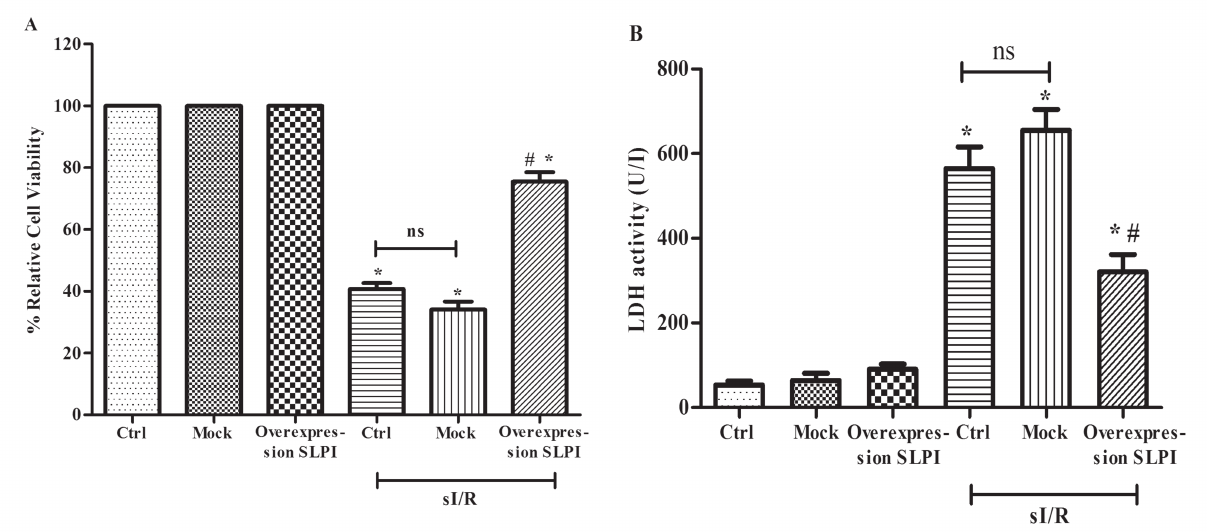
Figure 2: Determination of the effects of overexpression of rhSLPI in H9c2 cells subjected to sI/R. Three cells groups, including the parental H9c2 cells (Ctrl), the mock transfected cells, and the stable H9c2 cell lines overexpressing rhSLPI, were subjected to 40 min simulated ischemia (sI) followed by 24 h of reperfusion. (A) Cell viability and (B) cell injury were measured by MTT cell survival assay and released LDH activity assay. Each bar graph represents the means ± S.E.M for each of the three experiments. * p < 0.05 vs control group (ANOVA), # p < 0.05 vs among treated groups (ANOVA).